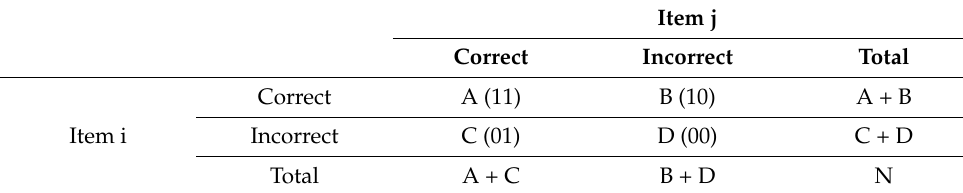
Table 1. Exemplar for rationale of order